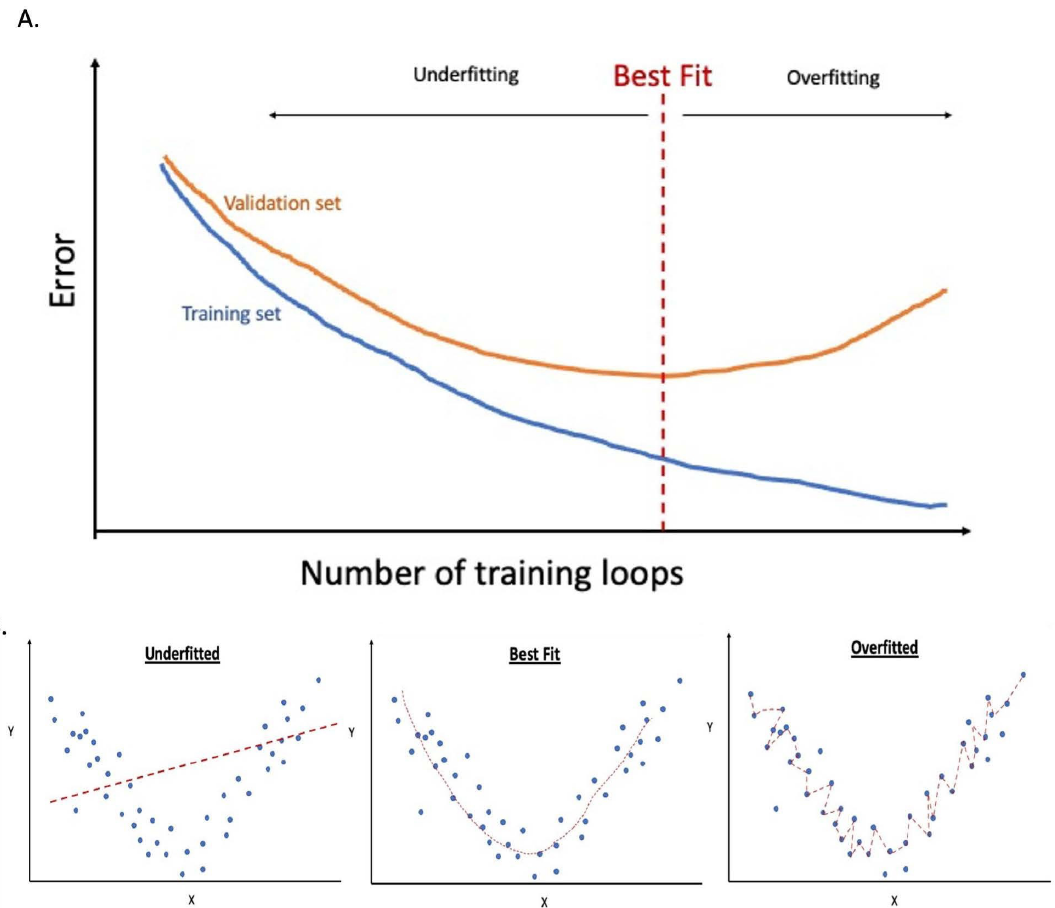
Figure 6. Graphs demonstrate overfitting and underfitting. Graph ( A ) compares the overall error against several loops conducted in the training sets. It shows the error in the validation set uptrends when overfitting occurs while the error in the training set continues to downtrend as the function memorises all the background noise and nonspecific details in the training sets. Finally, graph ( B ) demonstrates the underfitted, best fit, and overfitted concepts by using a simple best-fit trend lines model.